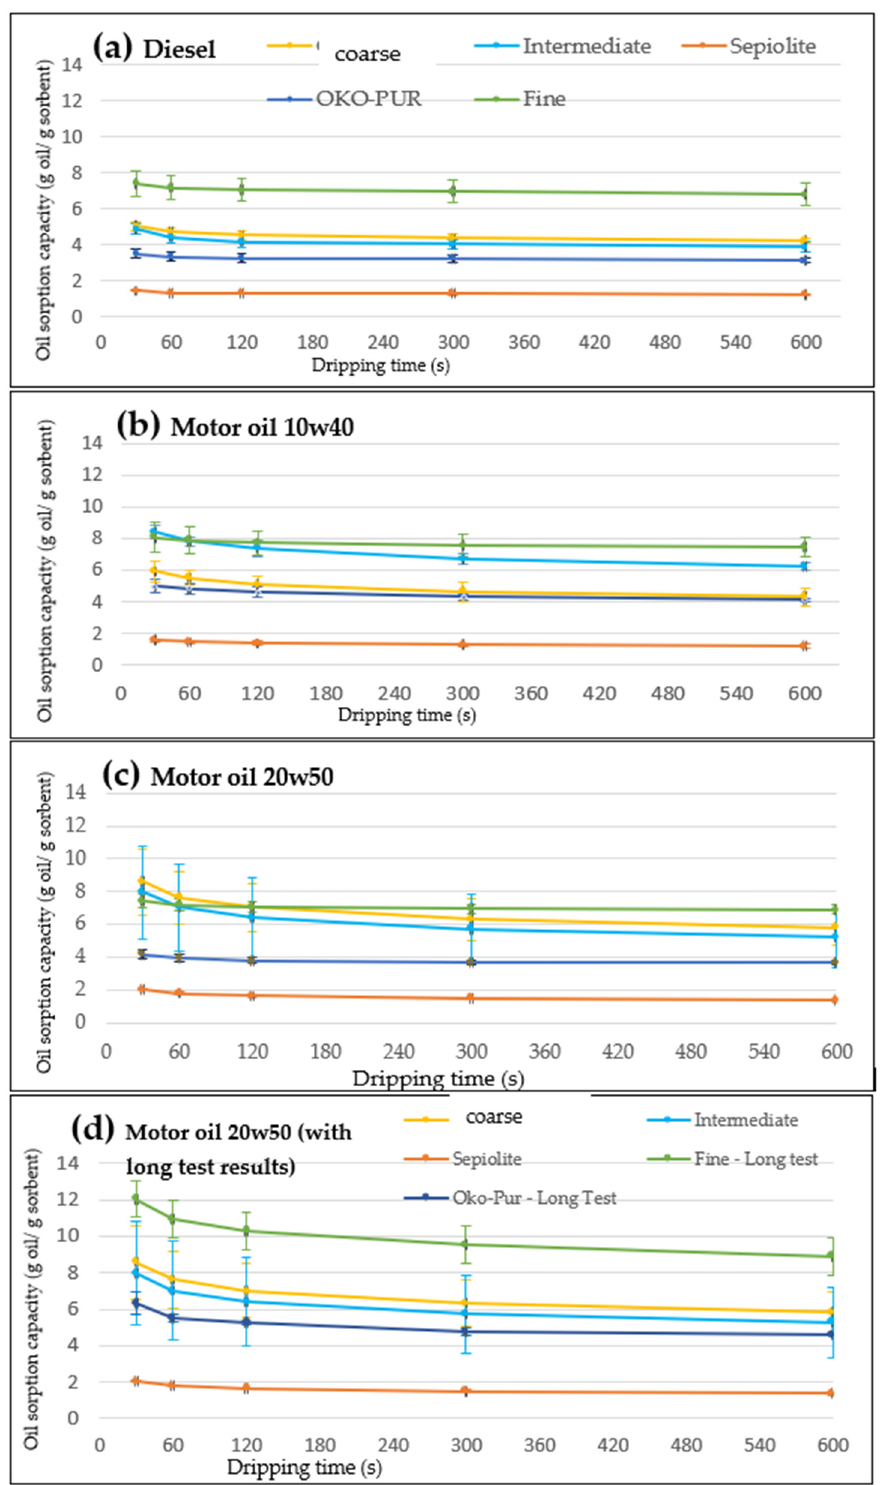
Figure 4. Results of the oil sorption capacity tests performed with ( a ) diesel, ( b ) 10w40 oil, ( c ) 20w50 oil, and ( d ) 20w50 oil in long test (contact time 24 h). The results obtained for the coarse PUF are indicated in the legend as “over 0.71” .